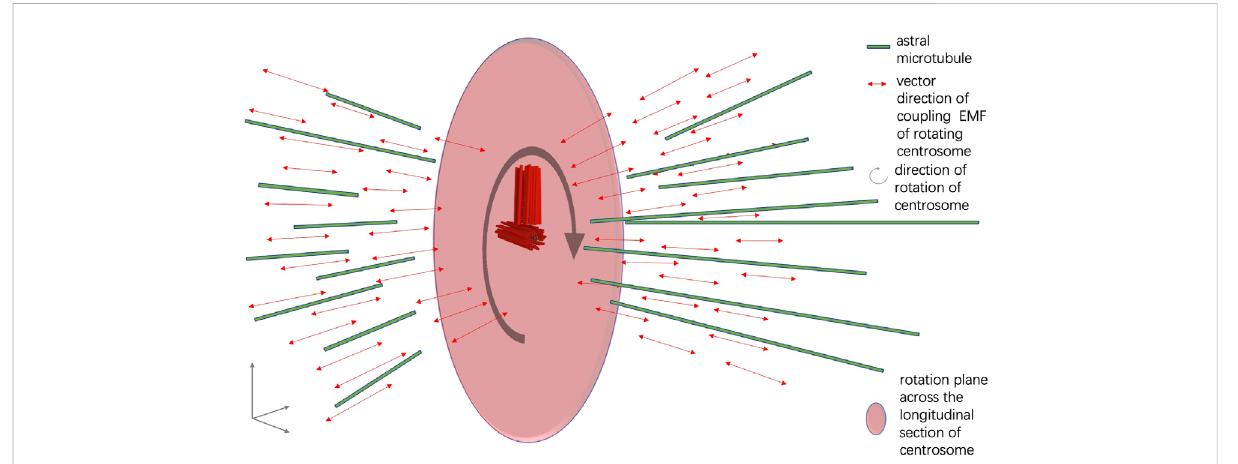
FIGURE 3 Illustration of the assembly of spindle microtubules orchestrated by EMF of the